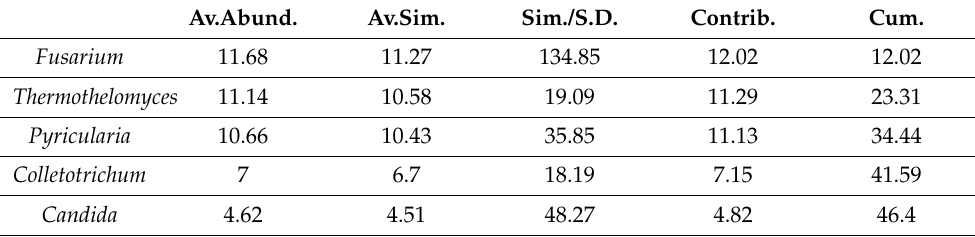
Table 4. Fungal genera which contributed the most to the global similarity of the community, according to SIMPER analysis. Average Abundance % (Av. Abund.), average similarity % (Av. Sim.), standard deviation (Sim./S.D.), contributed percentage % (Contrib.) and cumulative contribution % (Cum.).